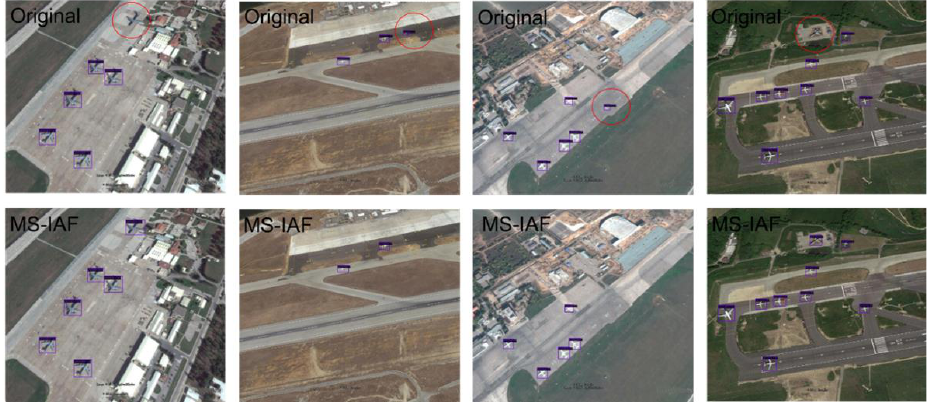
Figure 9. Comparison of test results on RSOD dataset.